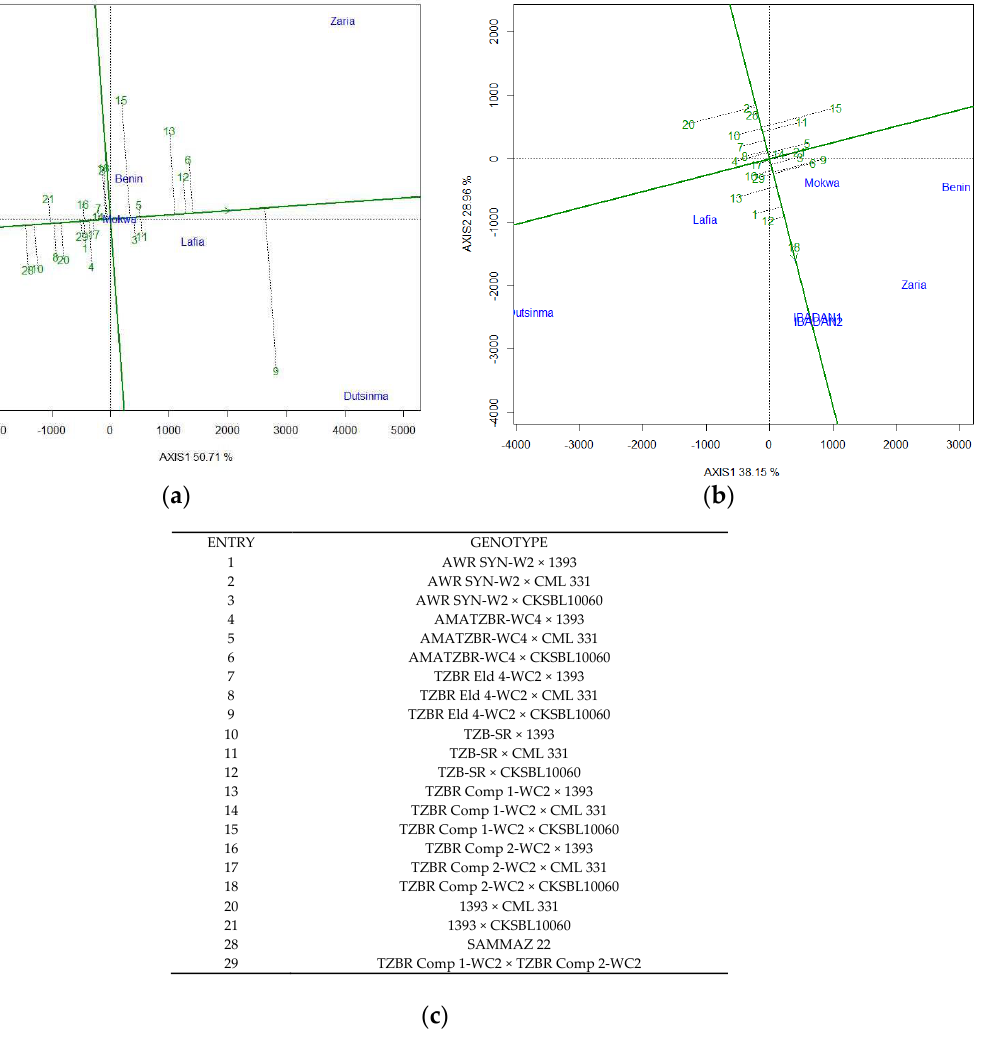
Figure 1. Genotype and genotype × environment (GGE) biplots (mean and stability view) for grain yield of maize hybrids evaluated under ( a ) natural fall armyworm infestation and ( b ) pesticide protected environment. ( c ) Information of genotype.